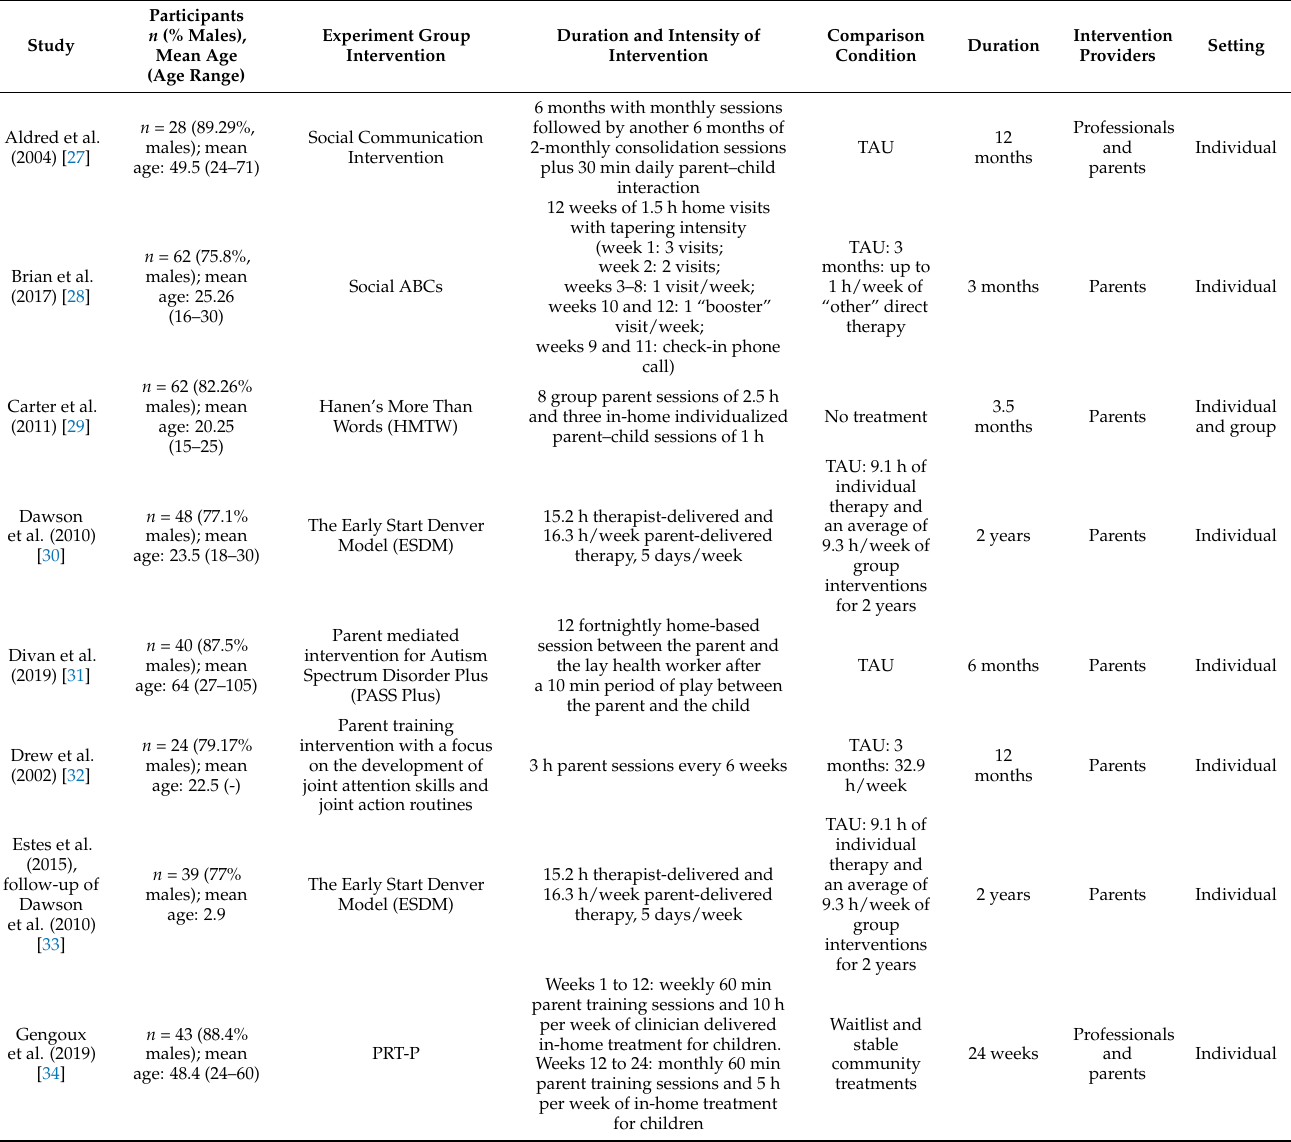
Table 1. Characteristics of the included